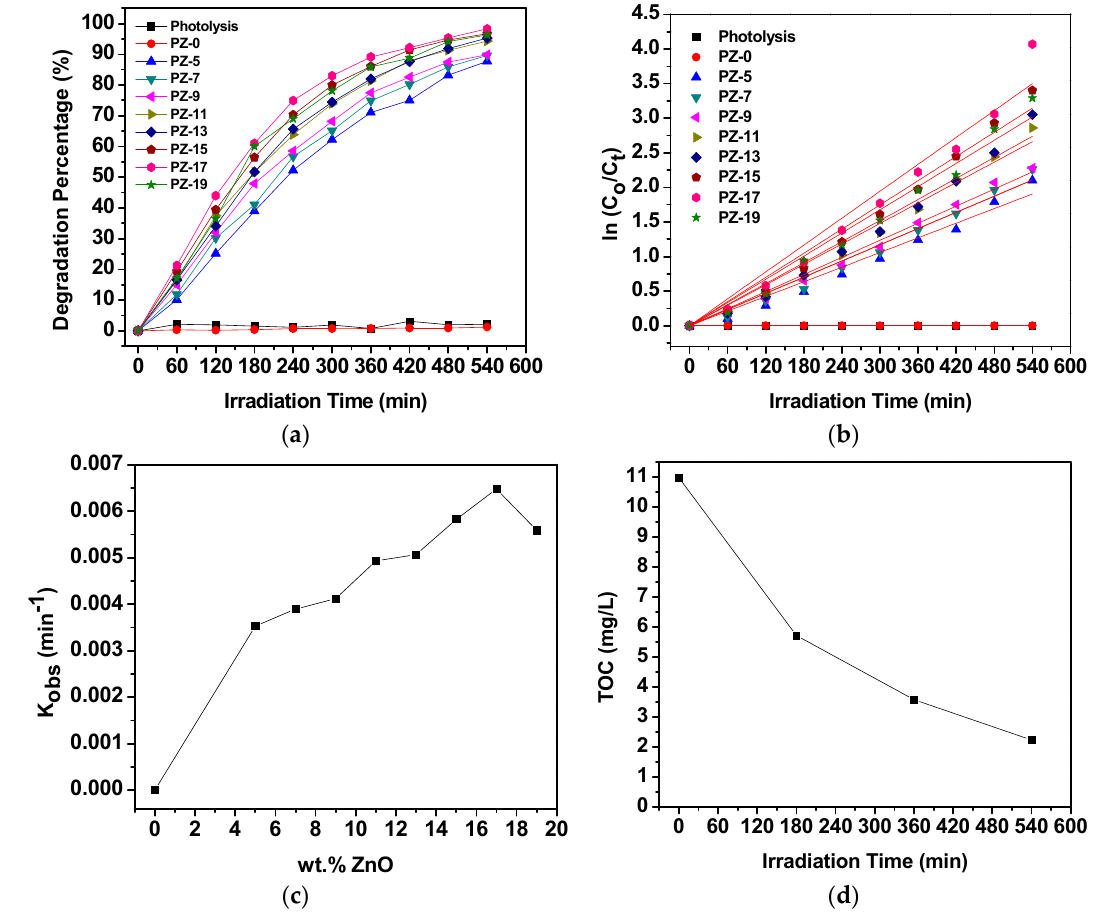
Figure 7. ( a ) Degradation percentages and ( b ) kinetics of the degradation of methyl orange (MO) by the PES/ZnO film photocatalysts with different ZnO loading (0–19 wt%), ( c ) first ‐ order rate constant, and ( d ) total organic carbon (TOC) evaluation for the concentrations of MO. [MO] = 10 mg/L; pH = 5.8; quantity of films = 2.